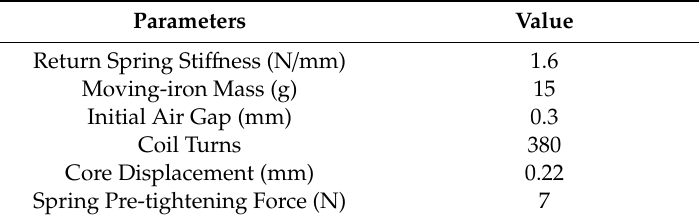
Table 3. Main parameters of the high-speed switch valve.